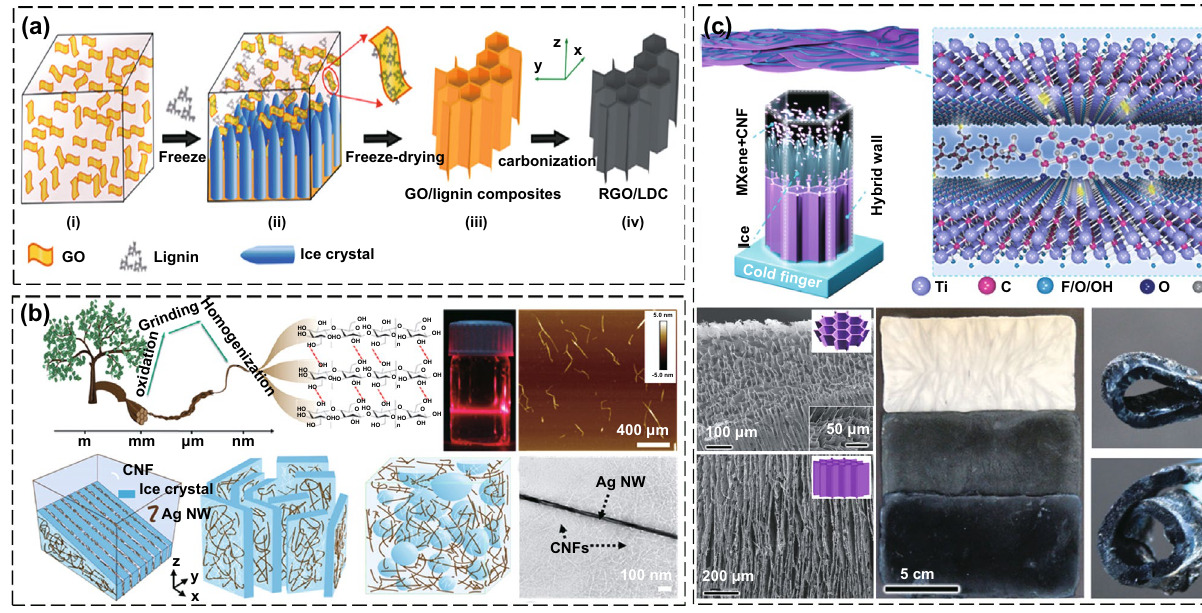
Fig. 9 Schematic illustrating the fabrication, SEM images and digital photos of a RGO/LDC composites, b AgNW/CNF aerogels, and c MXene/CNF aerogels [110–112]. Copyright © 2018 American Chemical Society. Copyright © 2020 Wiley–VCH. Copyright © 2020 American Chemical